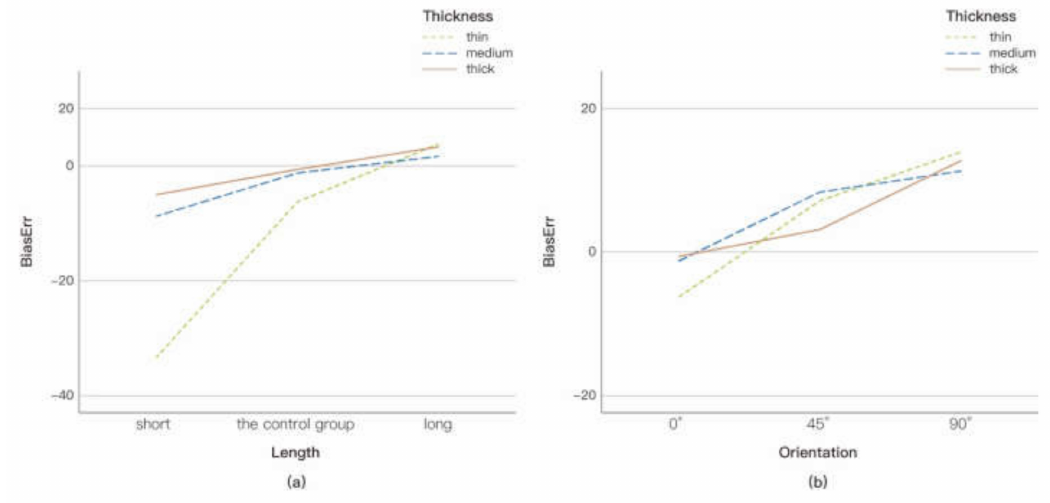
Figure 6. The trend of perception bias on ( a ) length and ( b )